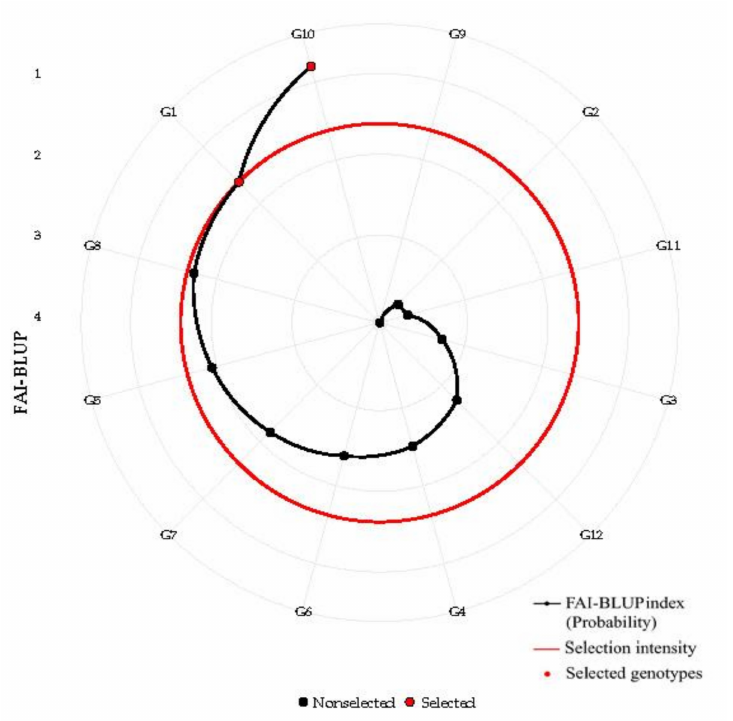
Figure 7. Genotype ranking and selected genotypes for the multi-trait stability index (FAI-BLUP index) considering a selection intensity of 15% (red circle). 1, 2, 3 and 4 indicate the multi-trait stability